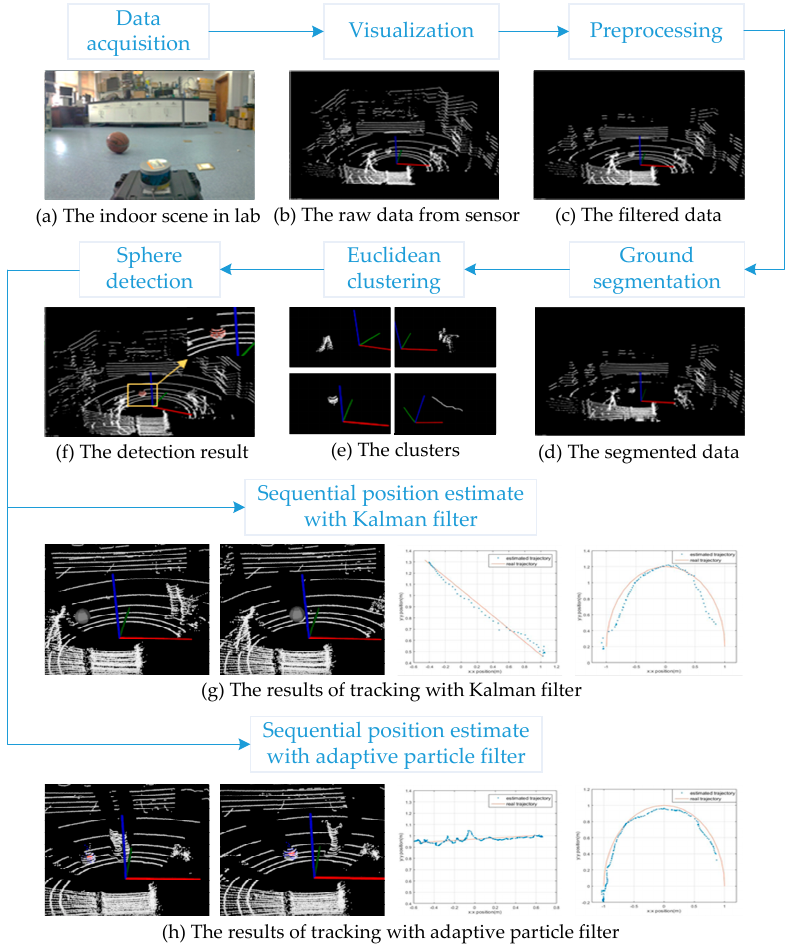
Figure 1. The tracking flowchart for a moving object.